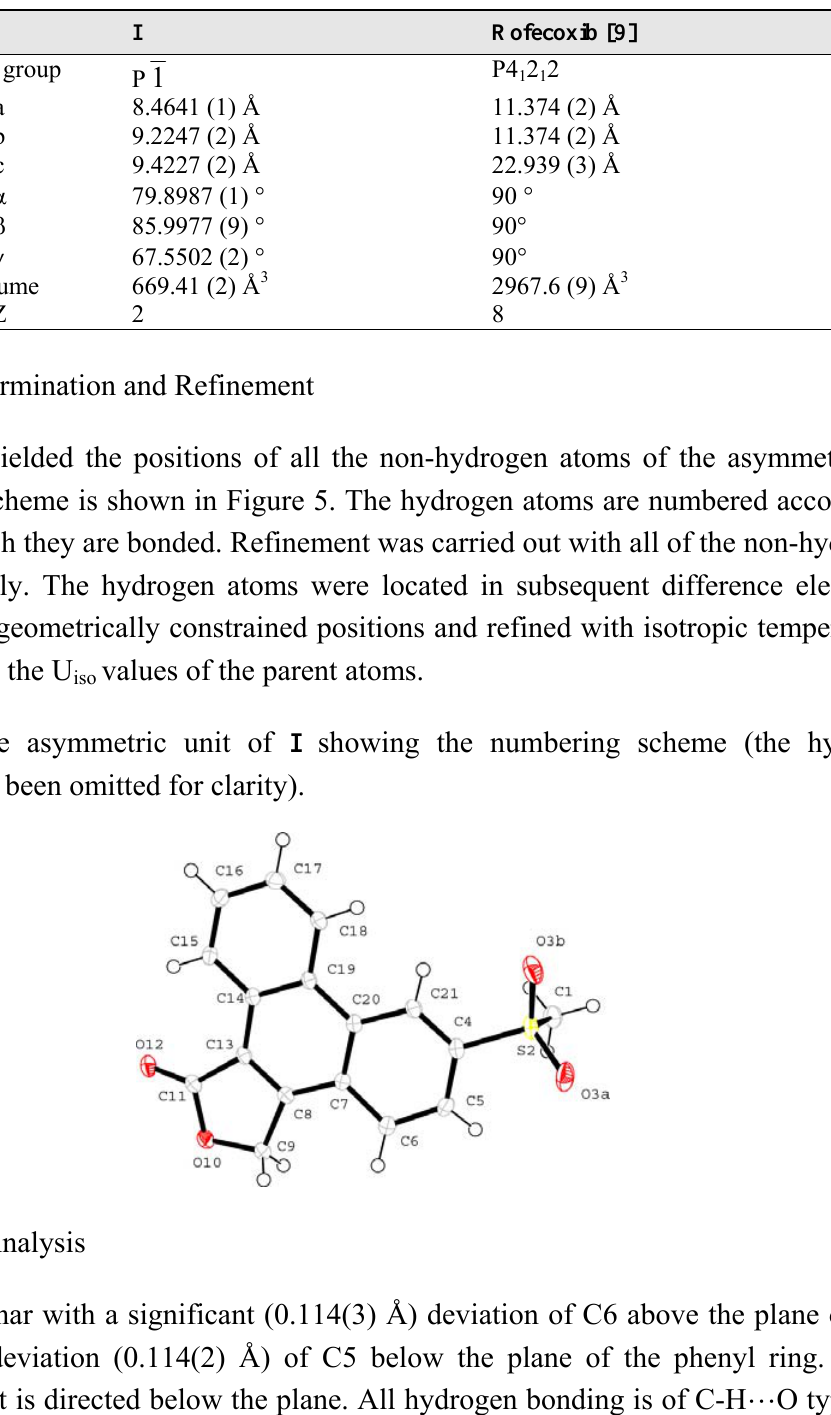
Table 1. Unit cell parameters of I and rofecoxib.